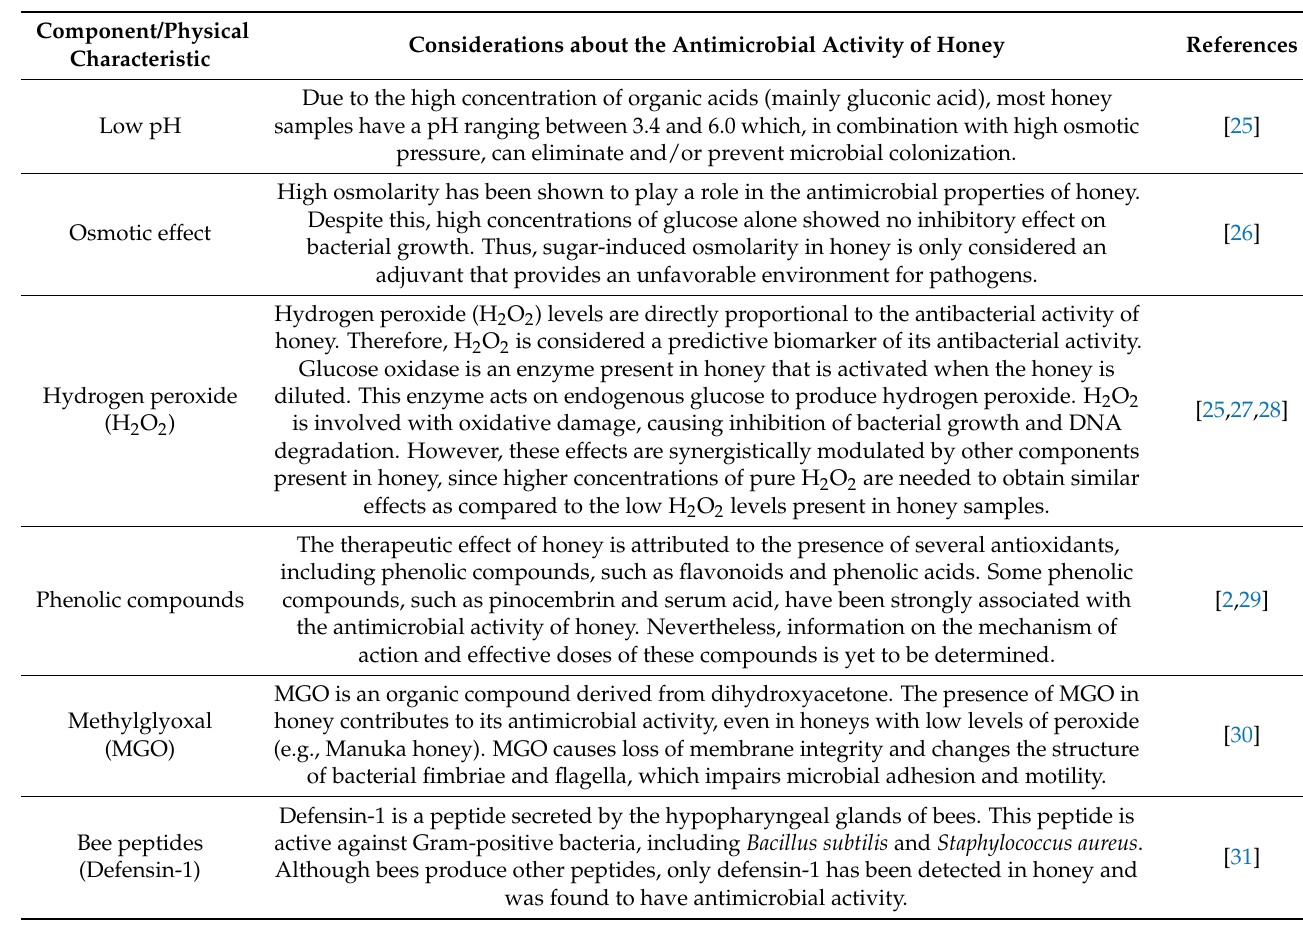
Table 1. Factors related to the antimicrobial activity of